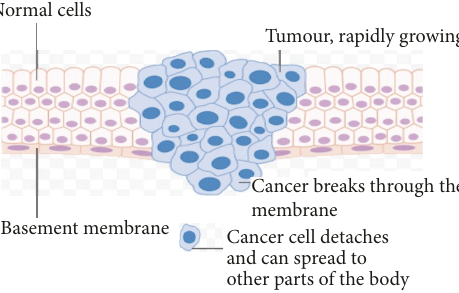
Figure 1: Schematic presentation of the basic properties of cancer cells (adapted from Cancer Research